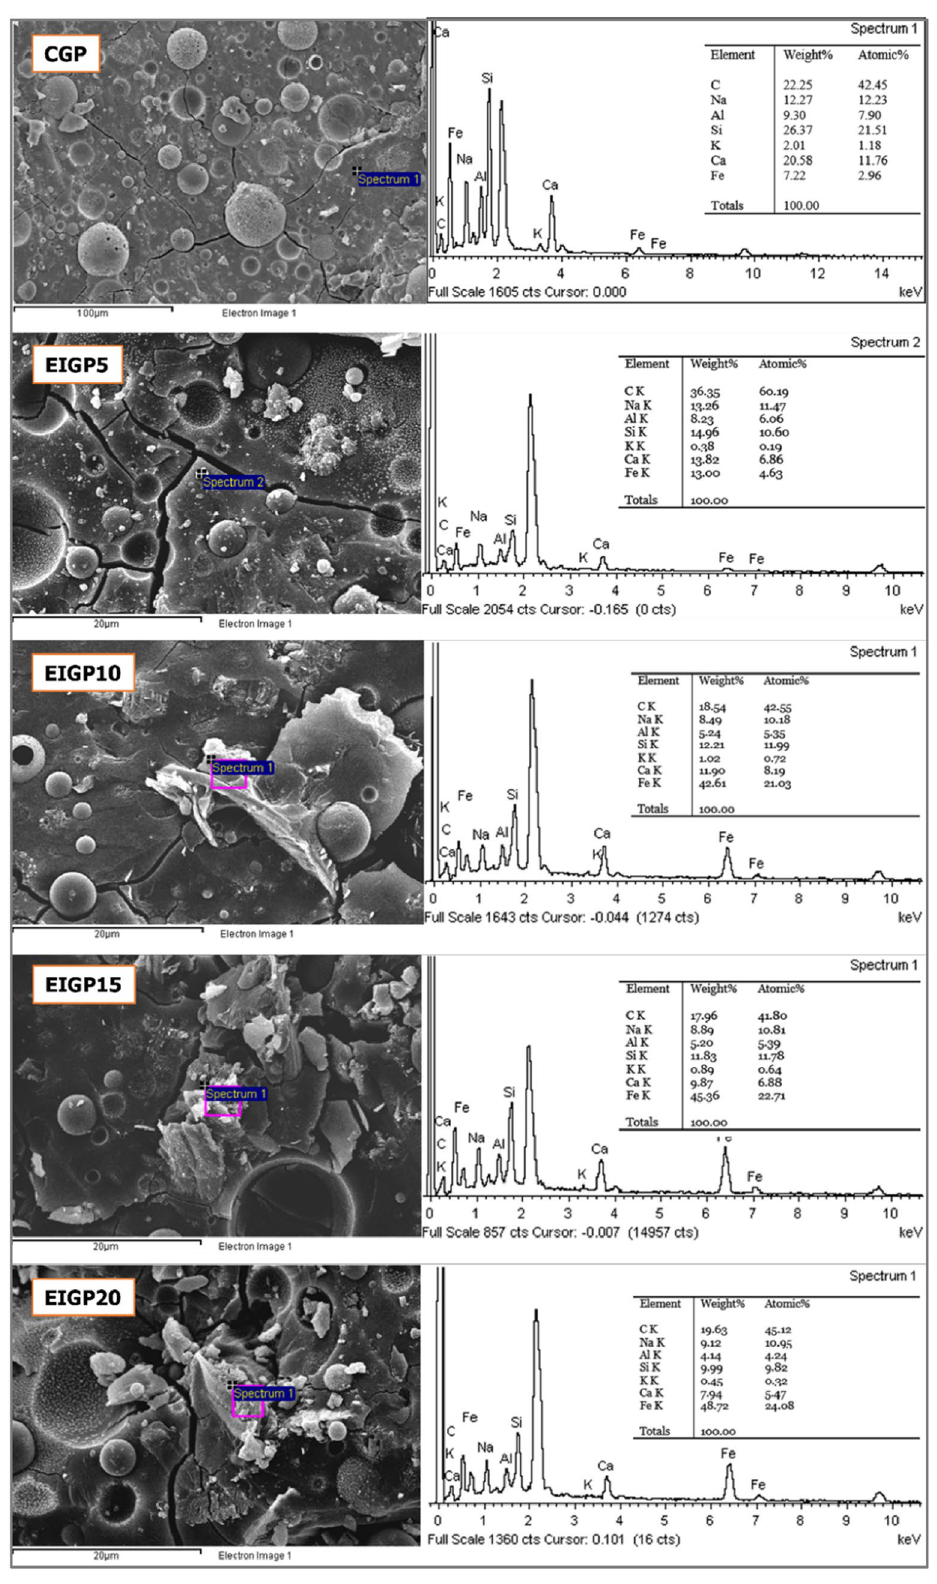
Figure 8. Detailed EDX spectral analysis of CGP and EIGP